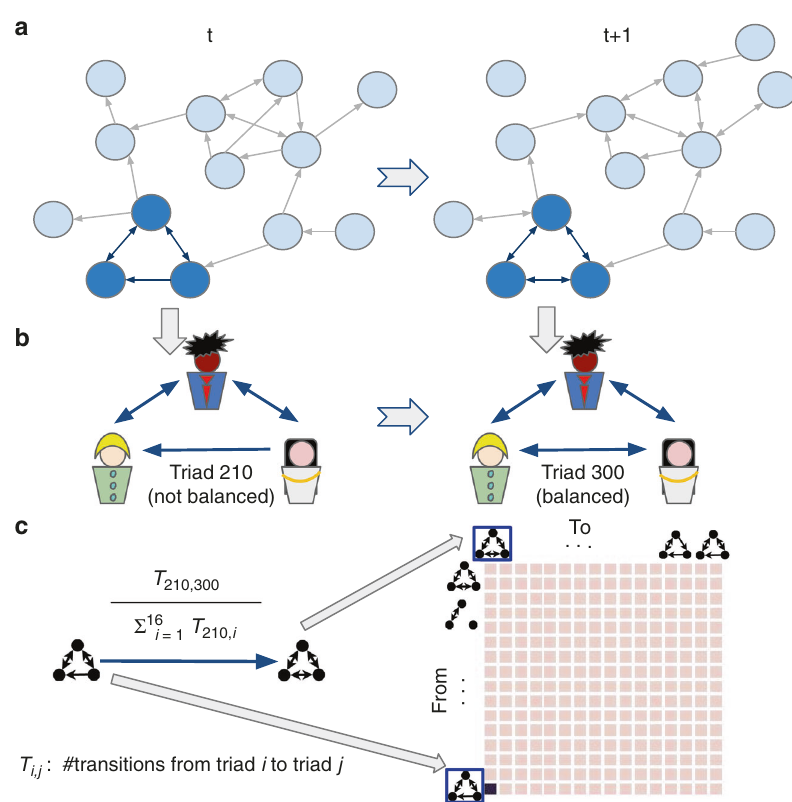
Fig. 1 Illustrative fi gure showing state transition probabilities from unbalanced or polarized triad state (210) to balanced triad 300. a For each period, we extract a directed graph of social IM ’ s among traders, and identify interpersonal relations by comparing the observed relations against a statistical null- model based on Wuchty et al. 35 . b We compute transition probabilities between periods for each observed triad. In this example, we demonstrate the con fi guration of sentiments for three illustrative nodes and compute the corresponding Markov transition probability from triad 210 – 300. c We repeat for each triad in each period, resulting in a 16 state (triad) Markov Chain capturing the complete transition probabilities between states and periods (See